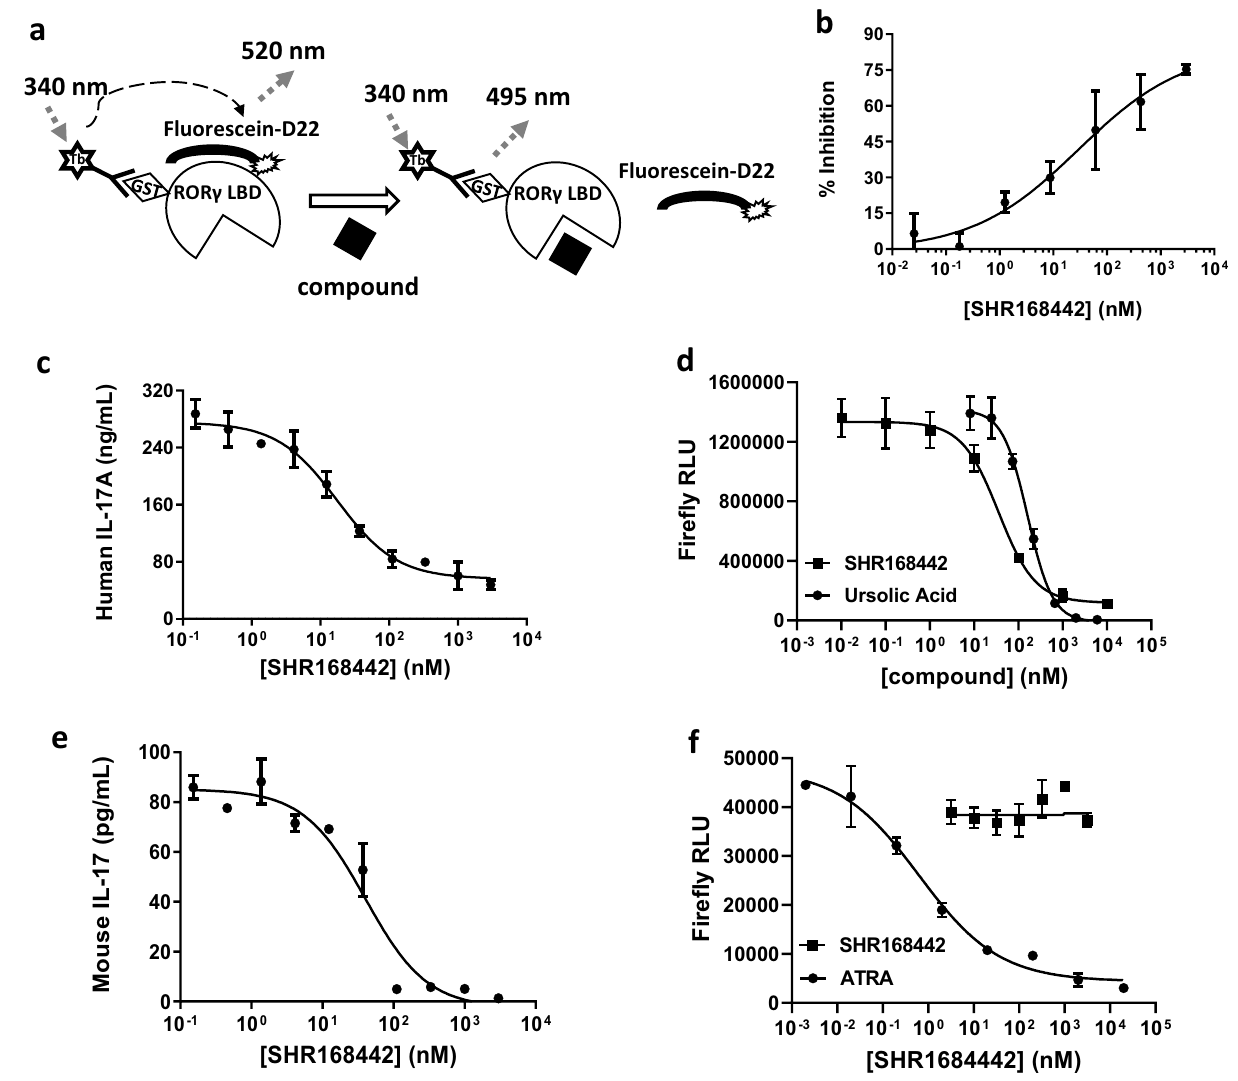
Figure 2. Biochemical and cellular on-target activities of SHR168442. ( a ) Principle of the LanthaScreen TR-FRET human RORγ LBD coactivator assay. The terbium (Tb)-anti-GST antibody indirectly labels the RORγ LBD by binding to the GST tag of the protein. Binding of the compound to RORγ LBD causes a conformational change that results in a decrease in the affinity of the receptor for a labeled coactivator peptide, fluorescein-D22. ( b ) Dose–response curve for SHR168442 as an antagonist in LanthaScreen TR-FRET human RORγ LBD coactivator assay. ( c-d ) SHR168442 inhibits IL-17 secretion from human PBMCs ( c ) and mouse splenocytes ( d ). ( e–f ) Effects of SHR168442 on RORγ ( e ) and RORα ( f ) luciferase reporter expression. Ursolic acid and ATRA were used as positive control in the assays, respectively. RLU = relative light units. Non-linear regression analyses were performed and IC 50 values determined using GraphPad Prism software. Representative curves are shown. Average of the measurement and its standard deviation are